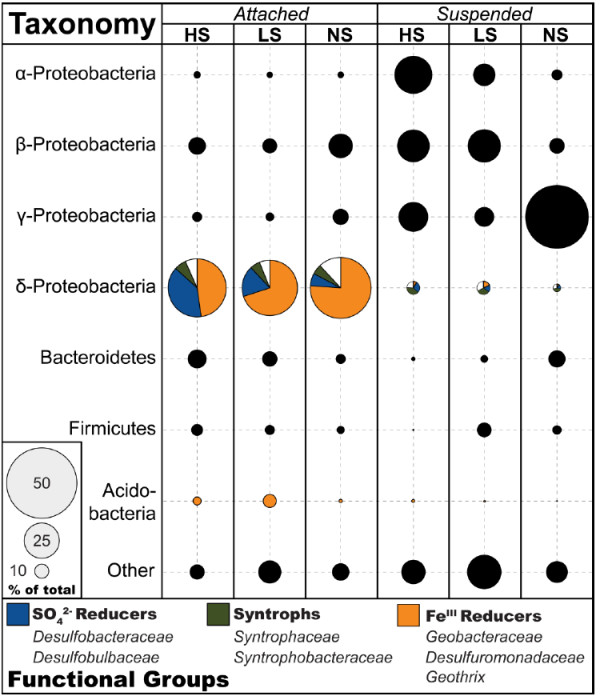
The taxonomy and relative distribution of bacterial populations attached to the sediment of in situ samplers. Sequences were classified to the genus level using Mothur [33] with the “Hugenholtz” taxonomic nomenclature in Greengenes [34]. The area of each circle is proportional to the percentage of sequences represented by that class within those wells, which are grouped together according to the concentration of sulfate in groundwater.